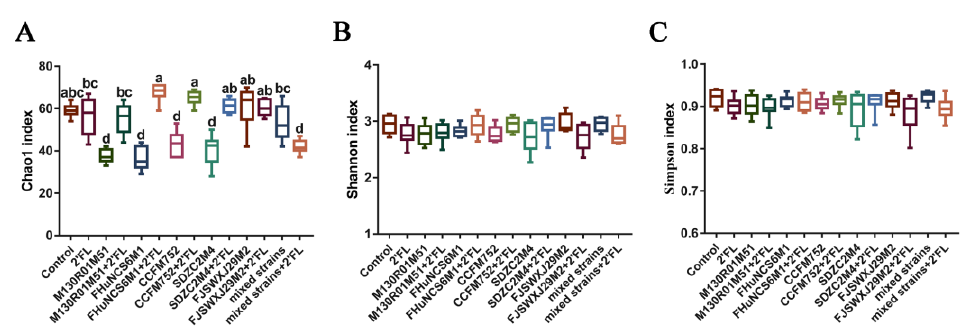
Figure 5. α diversity index of different groups (n=8 for each group). ( A ) Chao1 index, ( B ) Shannon index, and ( C ) Simpson index. Statistical differences were calculated by ANOVA followed by Duncan analysis and different letters indicate significant differences between the groups ( p <